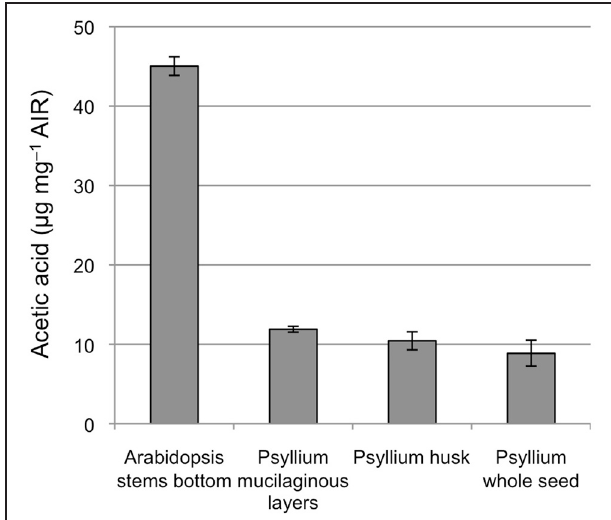
FIGURE 6 | Acetylation levels in alcohol insoluble residue of psyllium seed